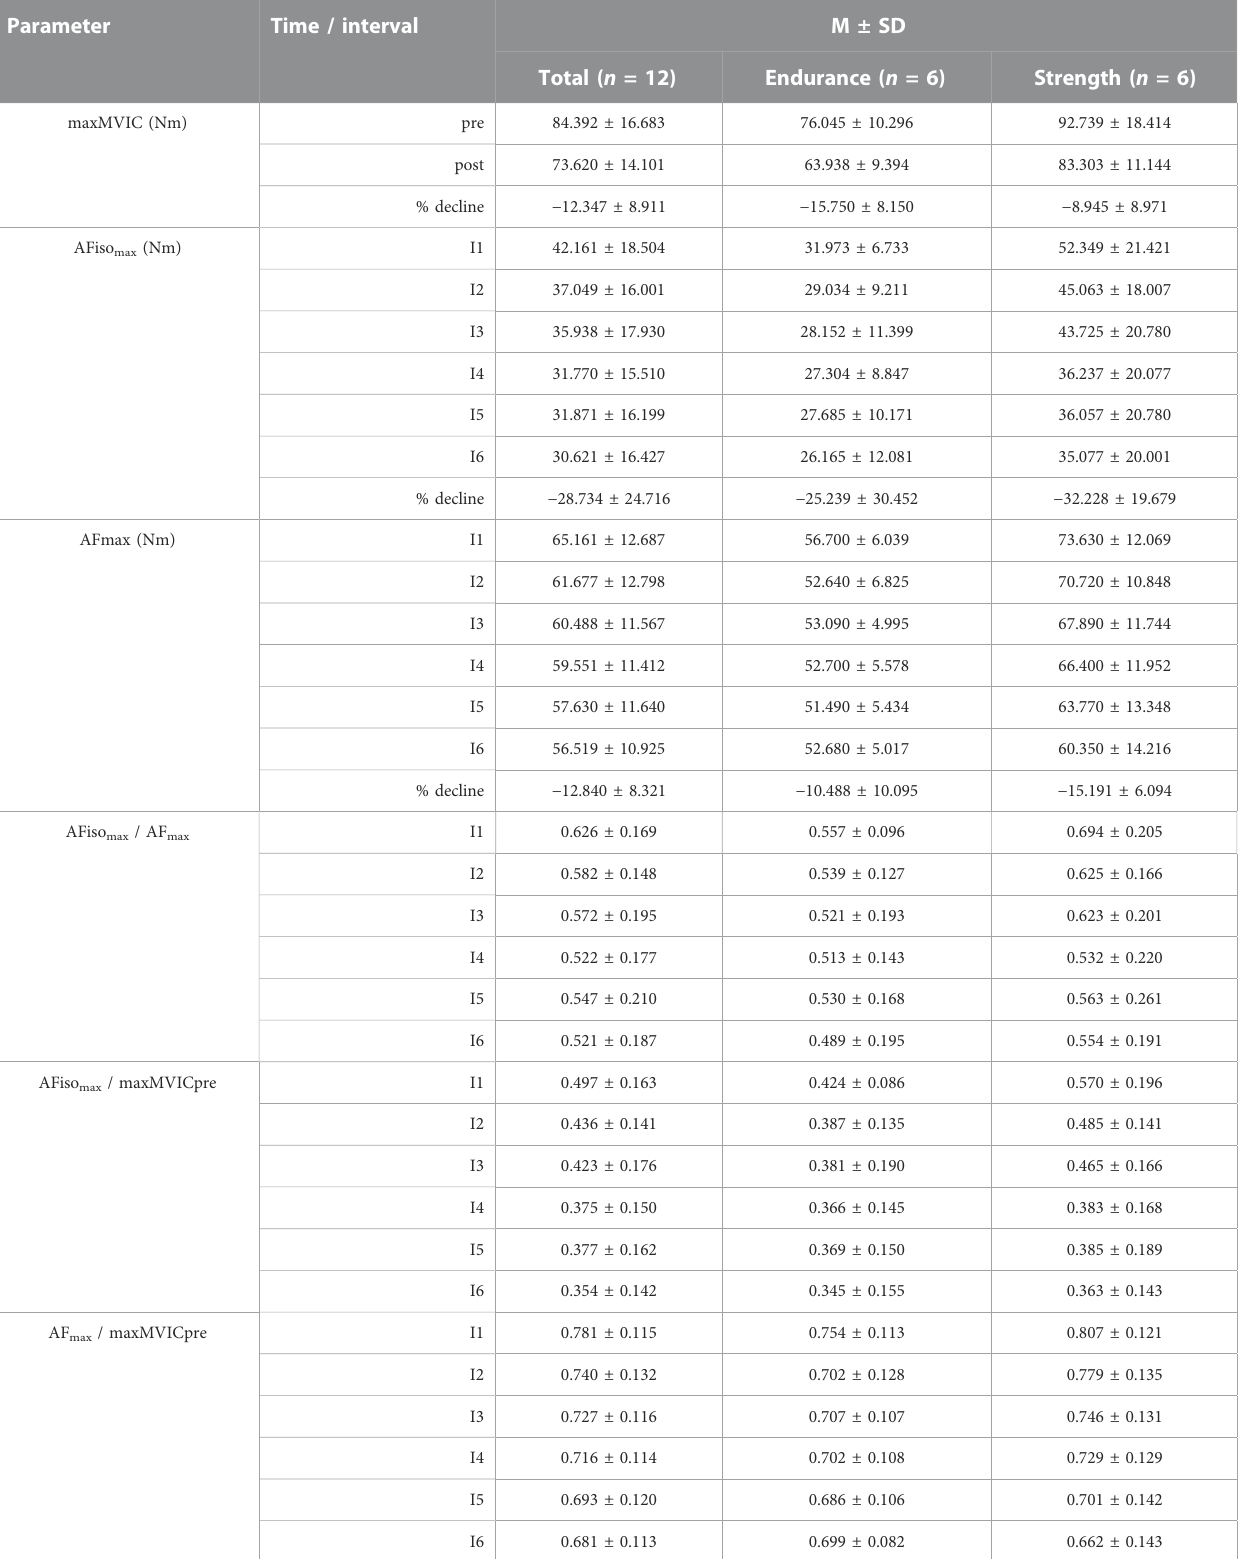
TABLE1Torquevaluesregardingintervalsandpercentagedecline.Arithmeticmeans(M)andstandarddeviations(SD)ofmaximalvoluntaryisometriccontraction (MVIC, Nm) before (pre) and after (post) AF trials, maximal isometric Adaptive Force (AFiso max , Nm), maximal AF (AF max , Nm), and their ratios regarding the six intervals (I1 – I6) considered for the whole sample ( n = 12) and for each sports group separately (endurance, strength) are displayed. Furthermore, M ± SD of the percentage decline (%) from pre to post for maxMVIC and from start (max. of the fi rst three trials) to end (max. of the last three trials) for AF parameters is